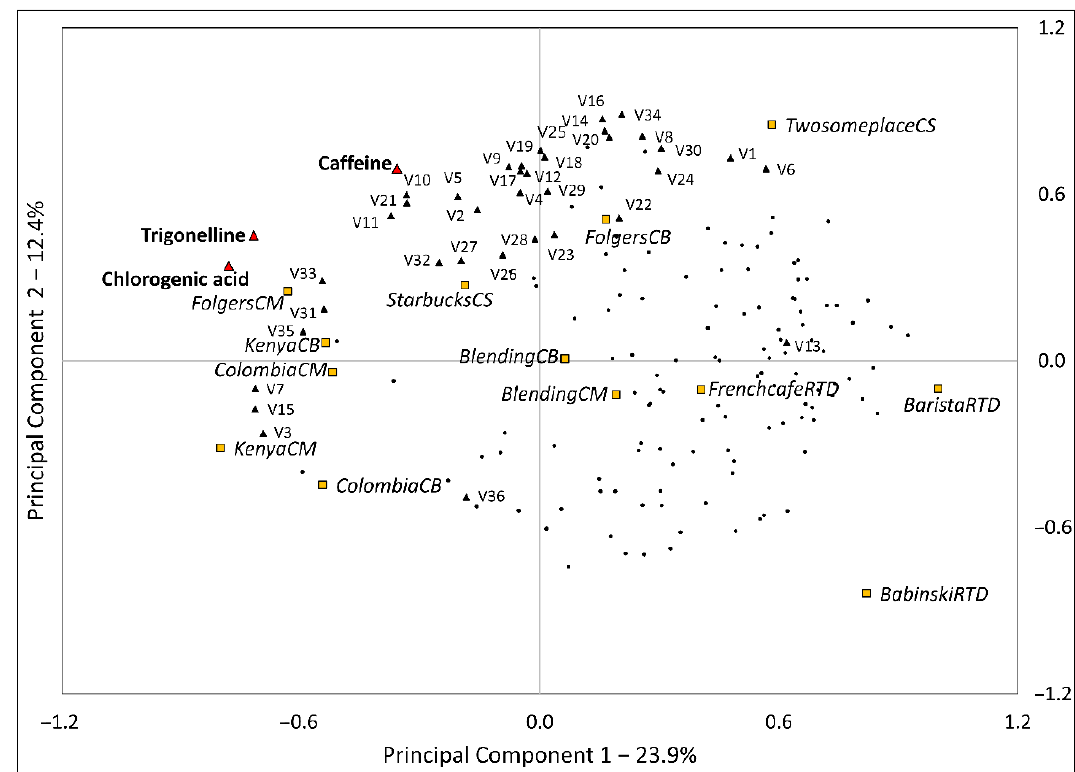
Figure 2. Internal preference map using consumers’ liking, coffee volatile and caffeine, chlorogenic acid, trigonelline, and coffee samples. V1–V36 stands for each volatile compound numbering in Table 4.